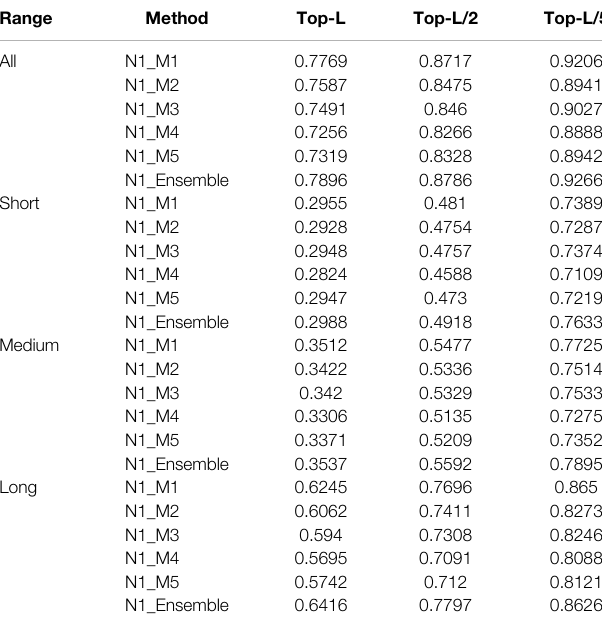
TABLE 2 | The prediction precisions of N1_M1/N1_M2/N1_M3/N1_M4/N1_M5/ N1_Ensemble for different sequence separations. Range Method Top-L Top-L/2 Top-L/5